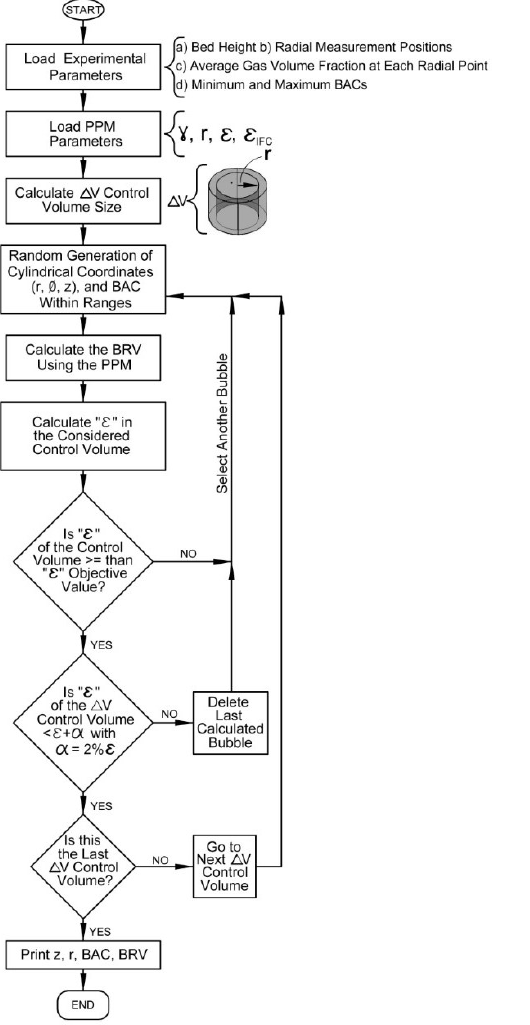
Figure 12. Description of various calculations steps involved in the application of the PPM.